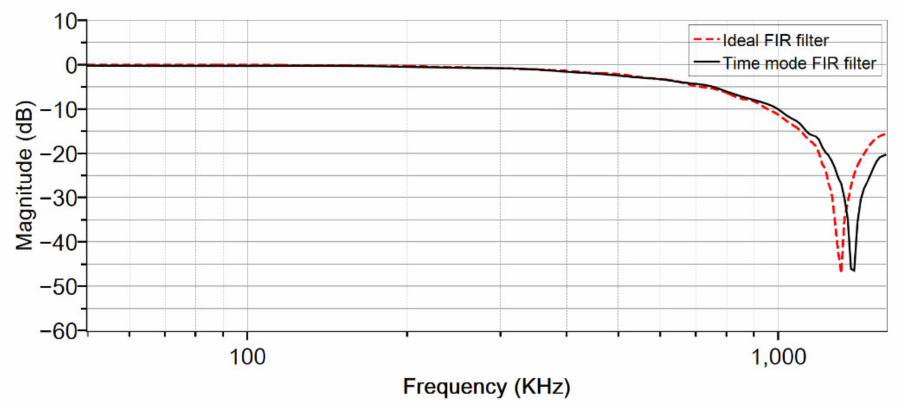
Figure 14. Ideal and time-mode FIR frequency response. The SNDR simulated results versus T in.peak are reported in Figure 15, where T in.peak is the amplitude of a sinusoidal signal of 50 kHz. The SNDR peak is at around 38.6 dB.